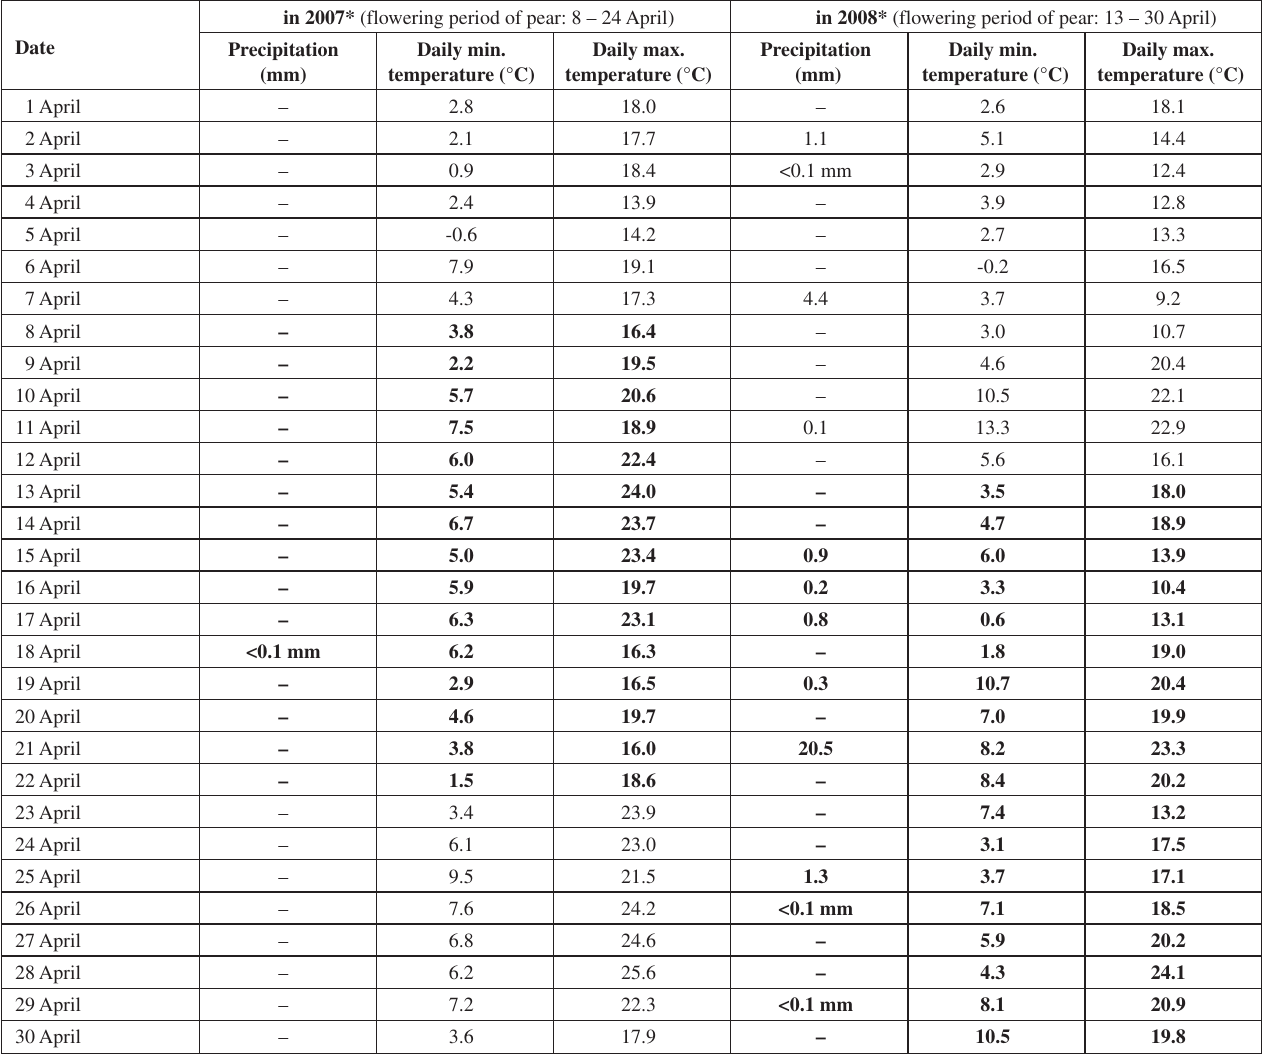
Table 1. Weather conditions in he flowering period of